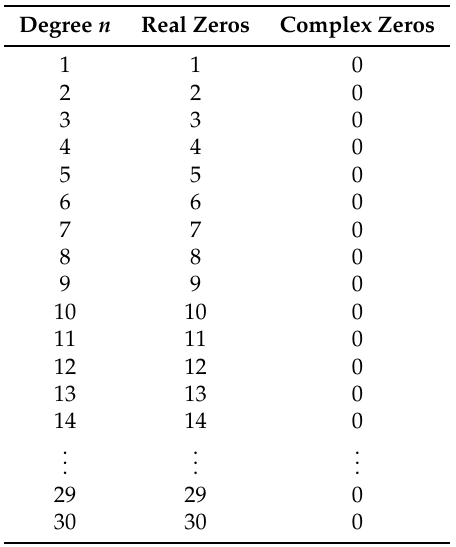
Table 1. Numbers of real and complex zeros of H n ( x , − 2 ) .